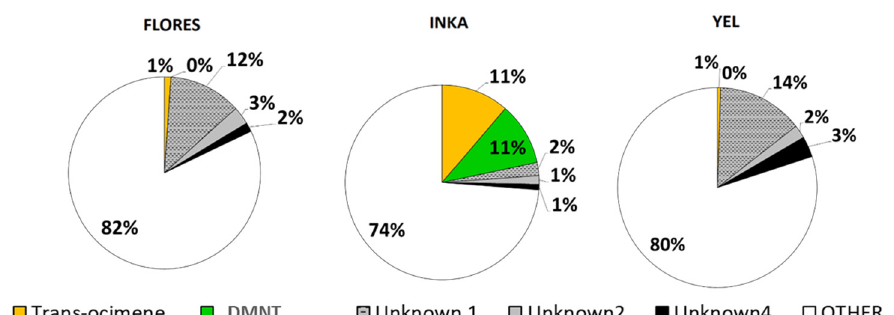
Figure 3. Significant variation in the relative proportions of constitutively expressed VOCs from undamaged P. lunatus plants. Based on these proportional differences, Flores and Yel were putatively grouped into one chemotype, with Inka representing a second chemotype.